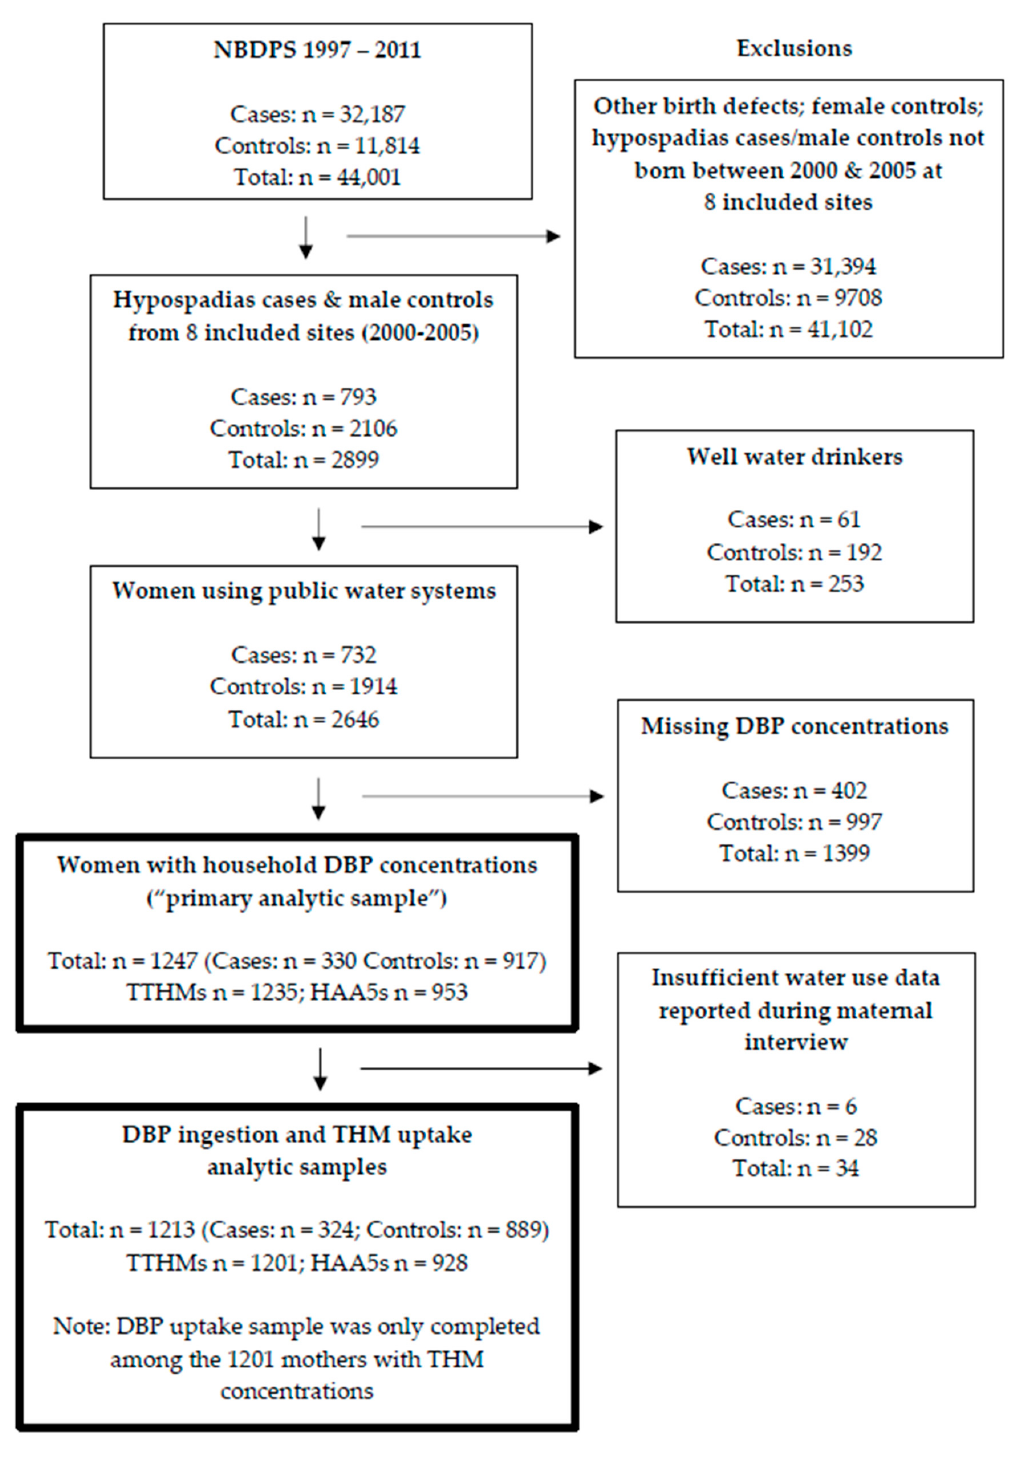
Figure 1. Inclusion and exclusion criteria for each exposure metric.